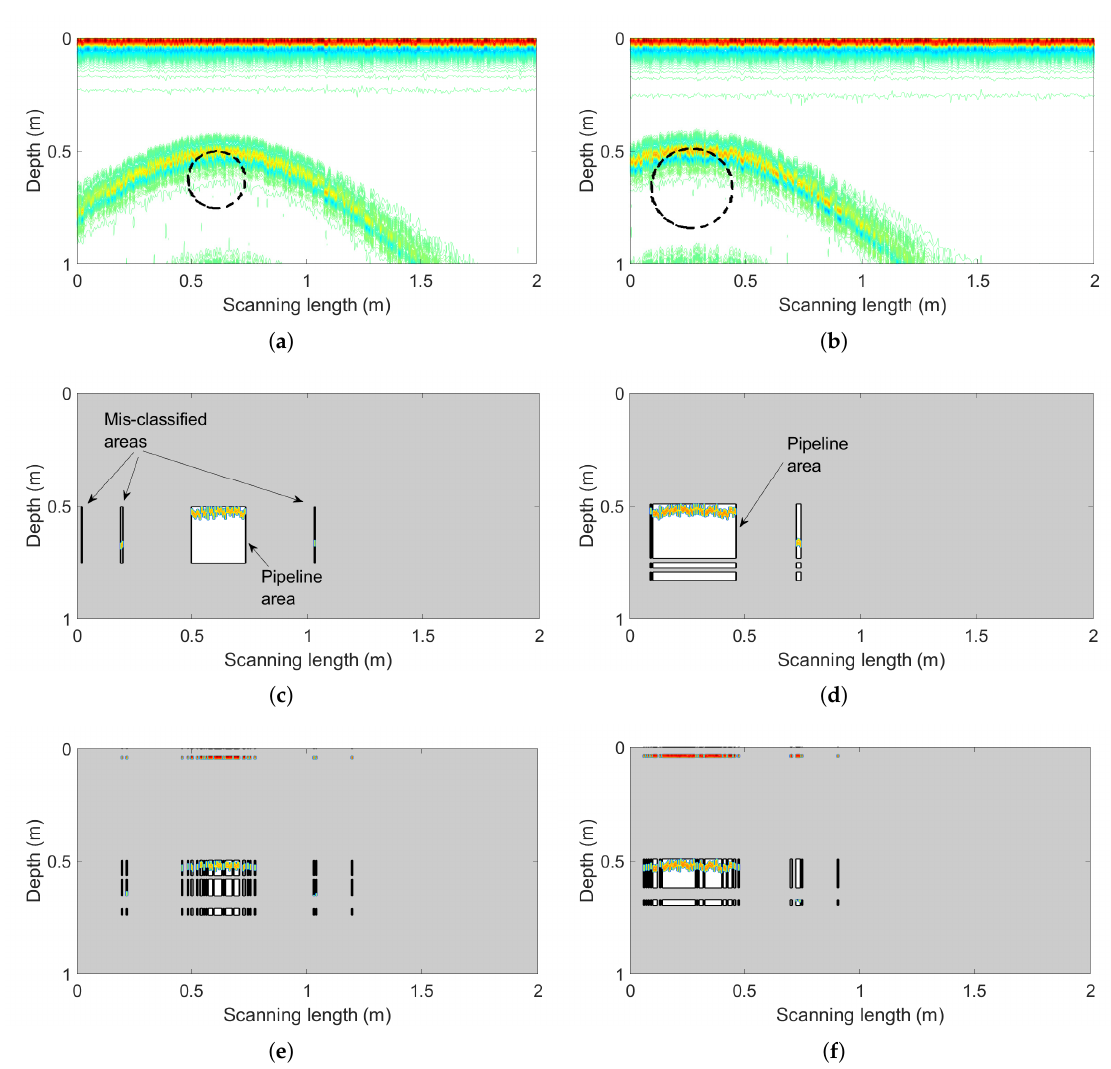
Figure 13. ( a ) The example profile with a single pipeline (seen in Figure 9a) considering surface roughness. ( b ) Another example profile with a single pipeline (seen in Figure 9b) considering surface roughness. ( c ) The reconstructed profile of panel (a) by the proposed learning framework. ( d ) The reconstructed profile of panel (b) by the proposed learning framework. ( e ) The reconstructed profile of panel (a) after the independent SVM for comparison. ( f ) The reconstructed profile of panel (b) after the independent SVM for